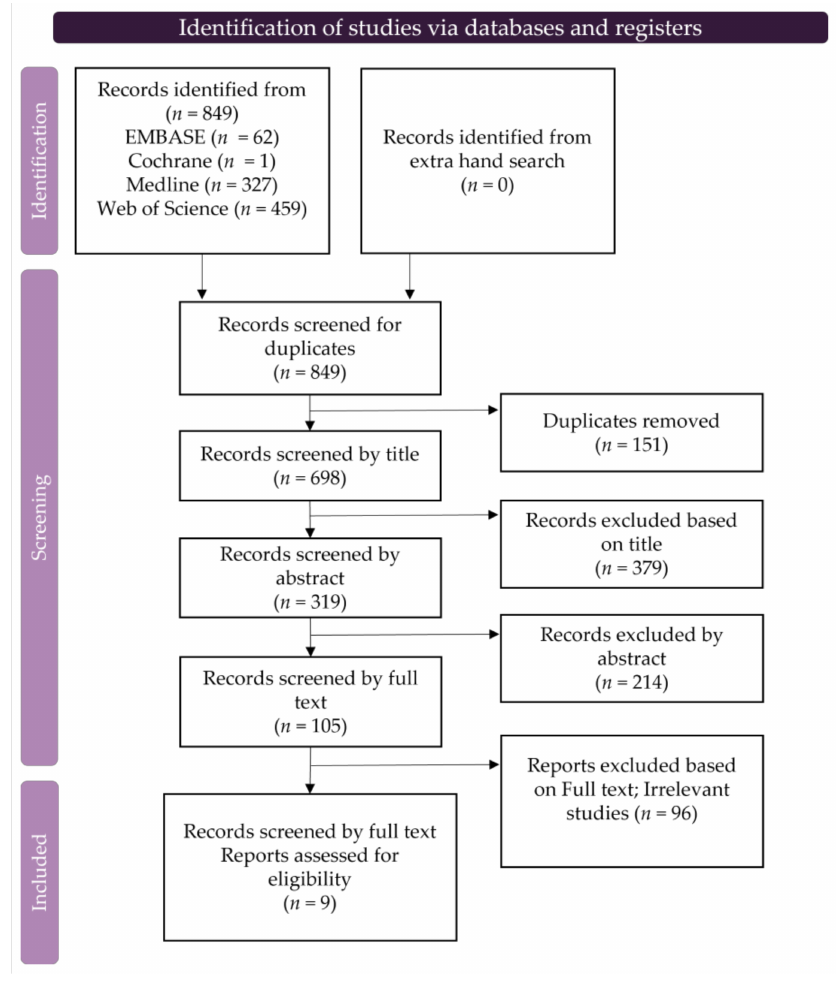
Figure 2. PRISMA flow chart of the search and selection